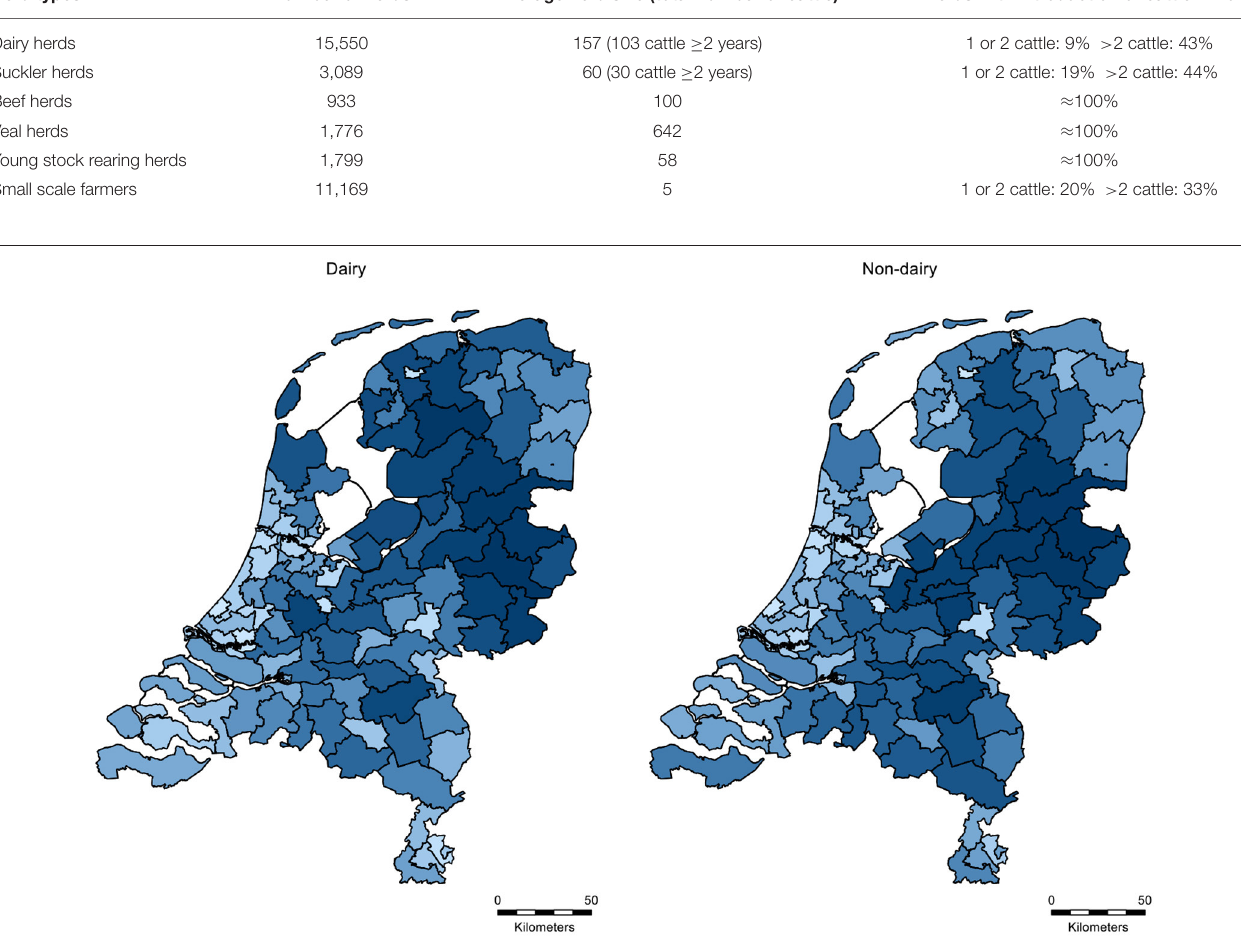
farmers where there is evidence of ongoing infection from bulk milk monitoring. This has been associated with an increased proportion of herds classified as unsuspected [on average 96.2% per measurement in 2019 ( Figure 8